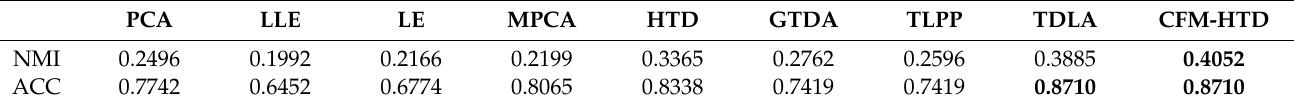
Table 4. ACC and NMI of different multisource fusion methods using dataset